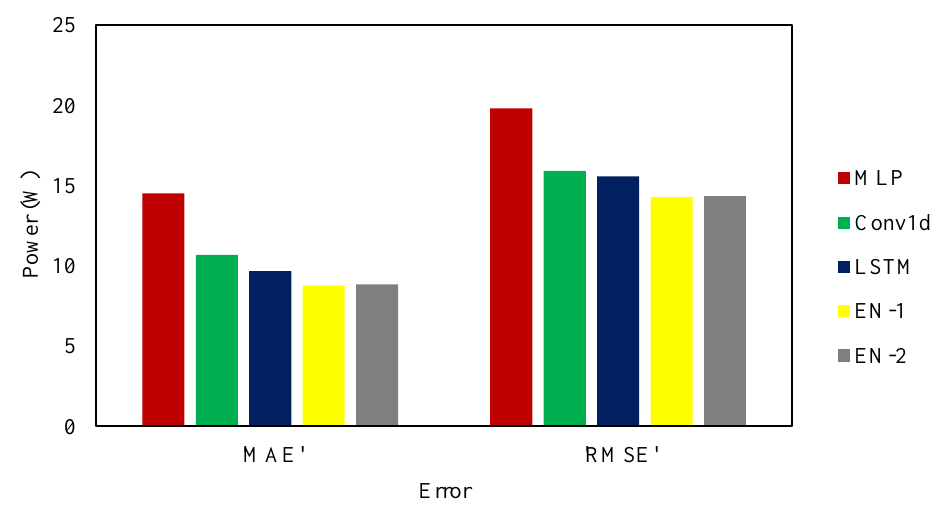
Figure 12. RMSE and MAE errors of models. Table 5. PV output forecasting error evaluation considering multiple models.